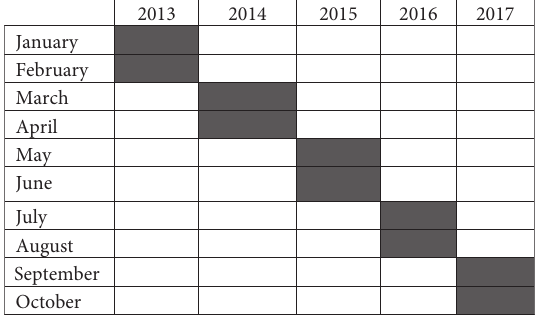
Figure 1: Distribution of medical records of cervical cancer pa- tients for months and years 2013-2017 (5